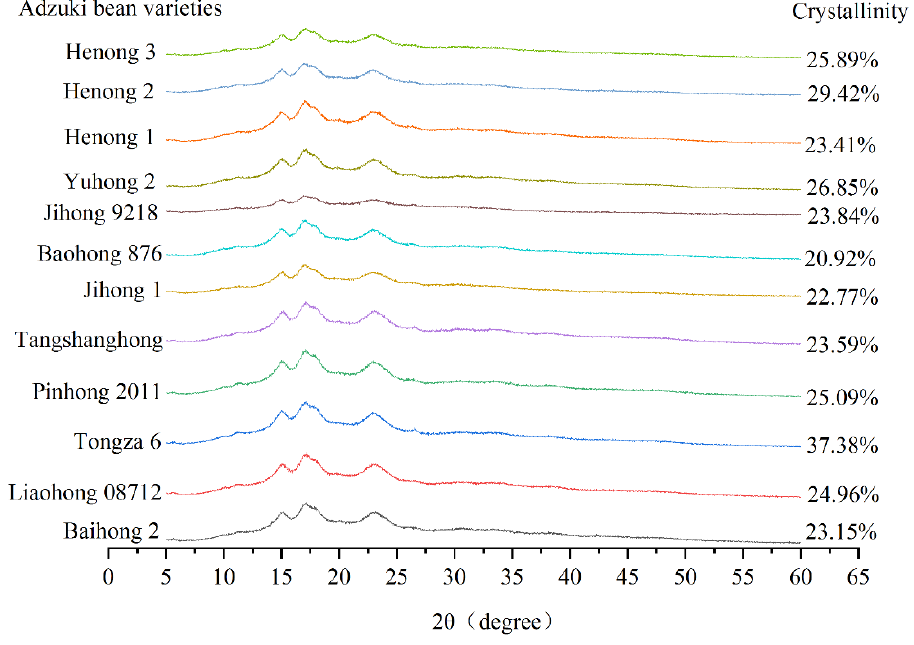
Figure 5. Starch crystallinity and X-ray diffraction patterns of different adzuki bean varieties.